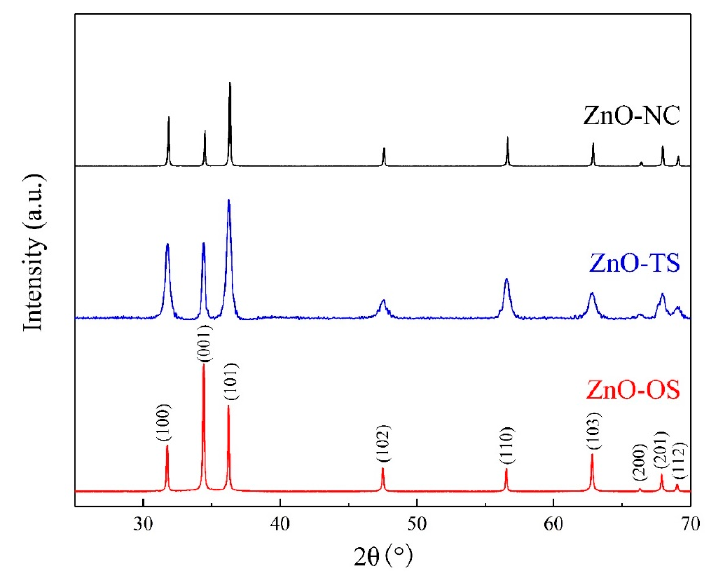
Figure 1. XRD patterns for all products.